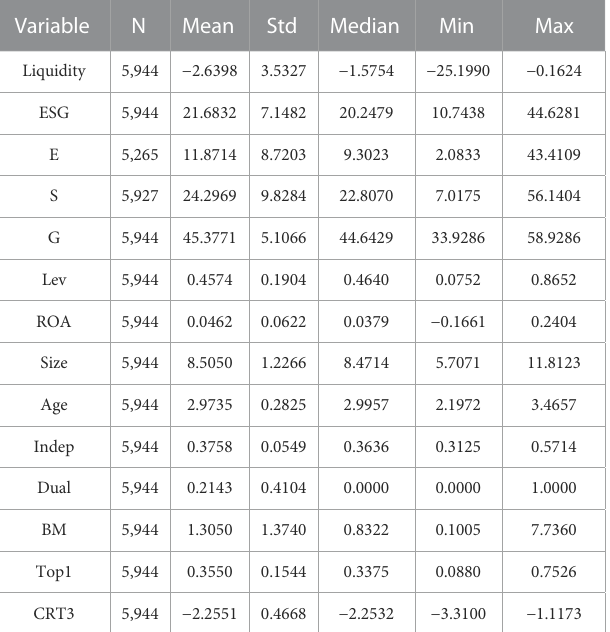
TABLE 2 Descriptive statistical results of variables.